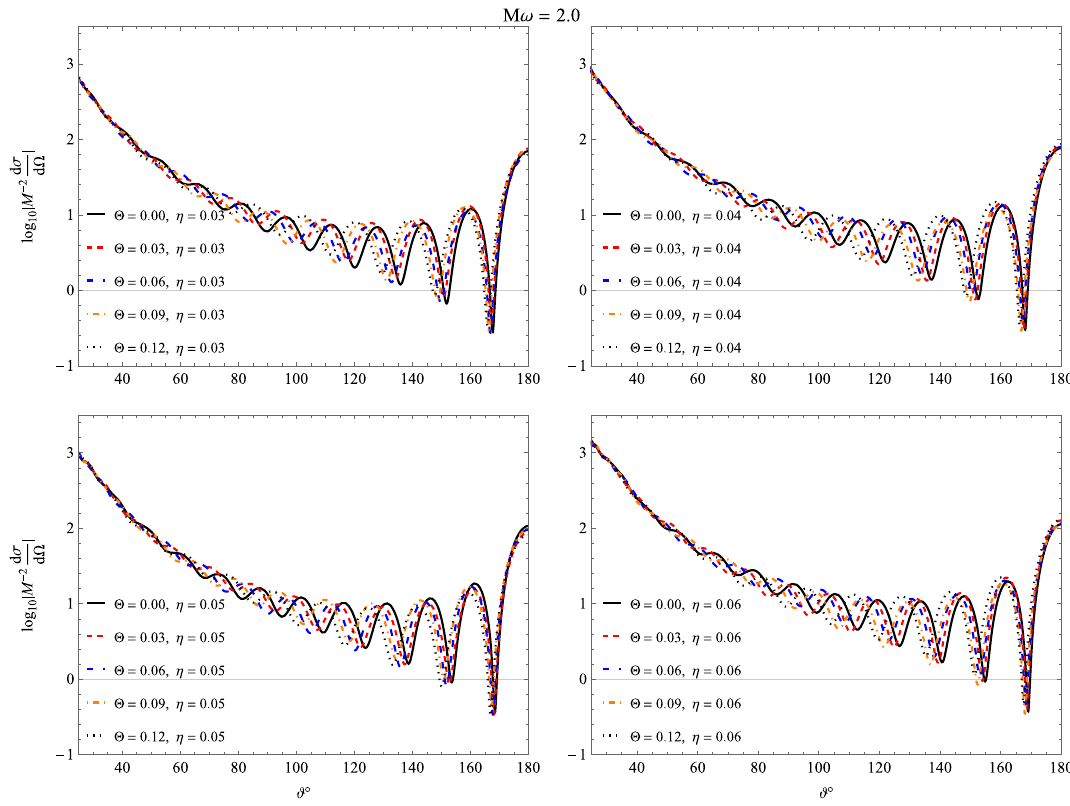
Fig. 8 Differential scattering cross section versus ϑ o (angle) for M ω = 2 .